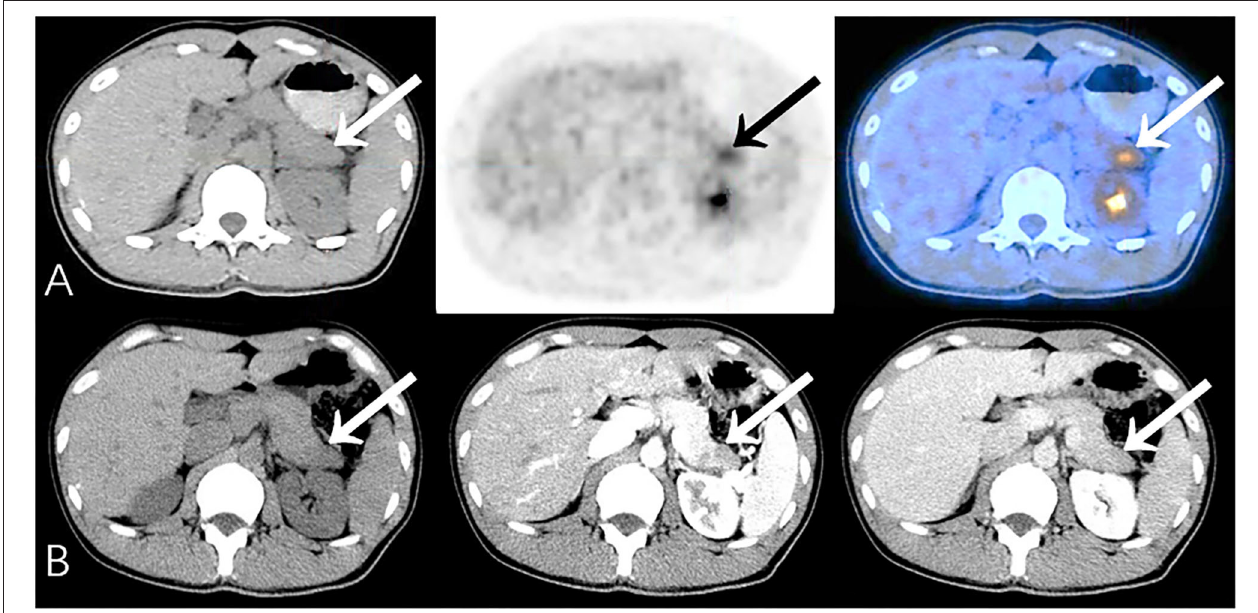
FIGURE 1 | Representative patient on PET/CT (False-Positive) compared to CECT (True-Negative): A 34-year-old male had abdominal pain for 2 months, worsening in the last 10 days. Serum CA19-9 was normal (34.1 U/mL). (A) PET/CT showed significantly increased 18 F-FDG uptake area in the tail of the pancreas (SUVmax 5.5). The edge of the lesion was indistinct and seemed to be closely related to the stomach wall; it was considered to be malignant. (B) Density of the lesion was relatively low at every phase. Fat spaces around the pancreas were clear on CECT (benefits from the higher resolution), suggesting chronic pancreatitis. Patient underwent distal pancreatectomy, and histopathology revealed chronic pancreatitis with small abscesses. No special complaints during follow-up ( > 23 months).